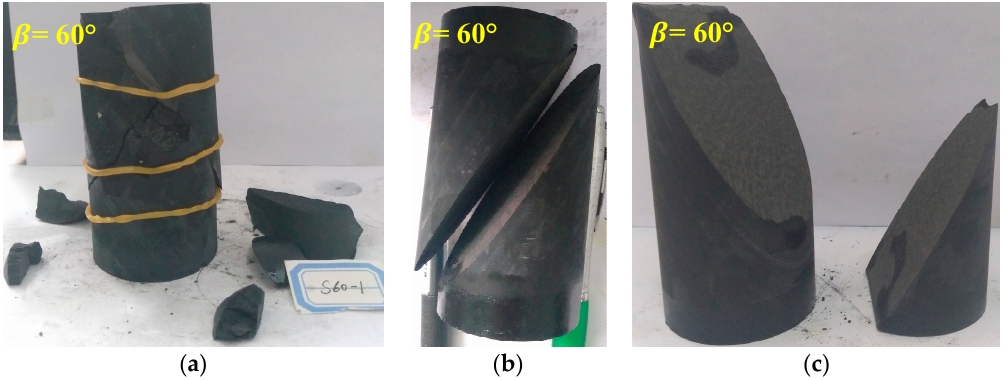
Figure 10. Different failure patterns of Shale-5 samples with inclination angle β = 60 ◦ under the confinements of ( a ) σ 3 = 0 MPa; ( b ) σ 3 = 60 MPa and ( c ) σ 3 = 100 MPa.